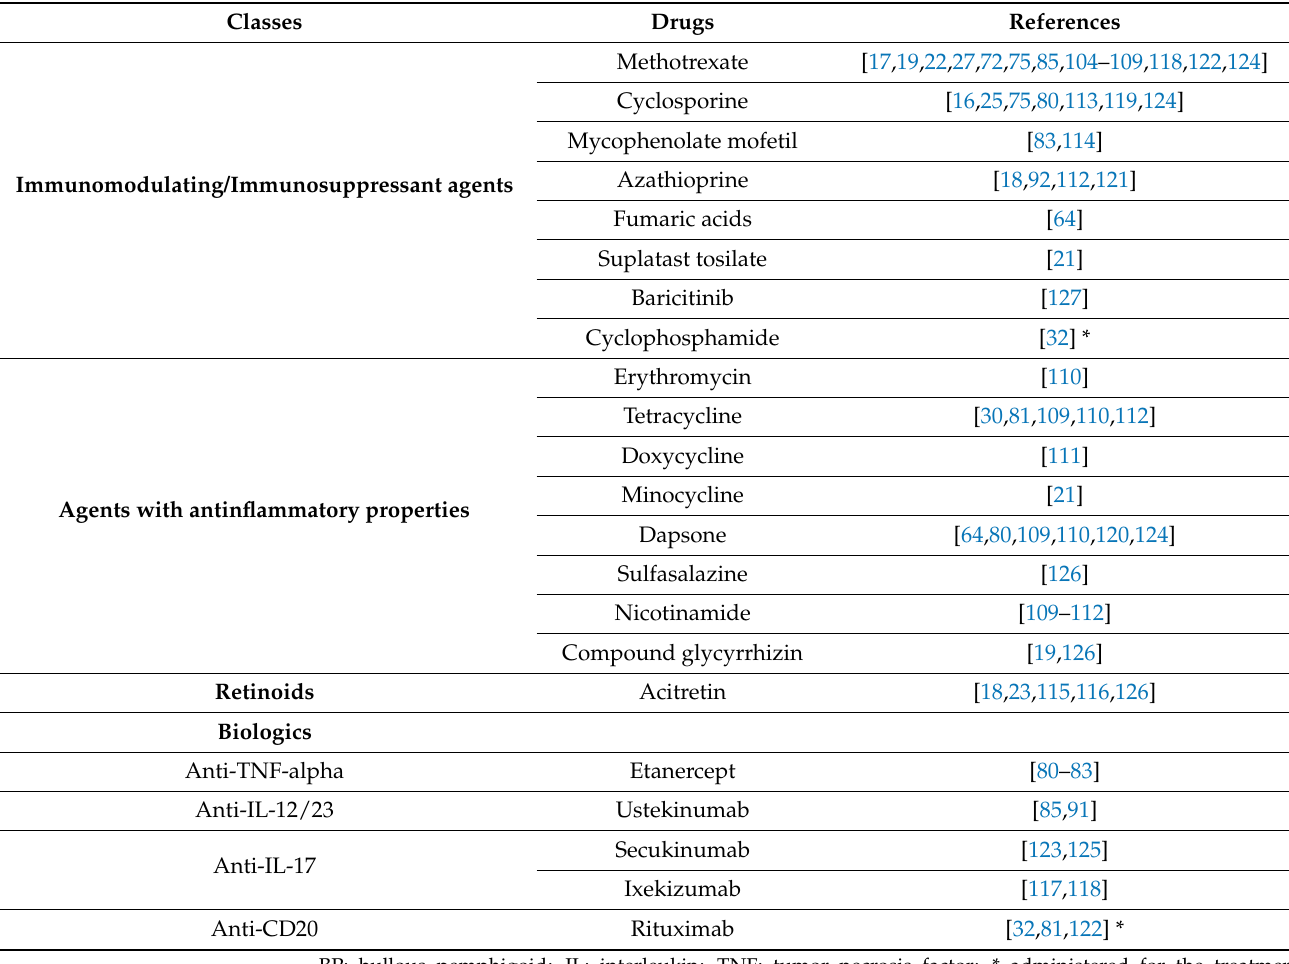
Table 1. Main reported treatments for psoriasis and concurrent BP, other than topical and systemic corticosteroids, used as monotherapy or in combination